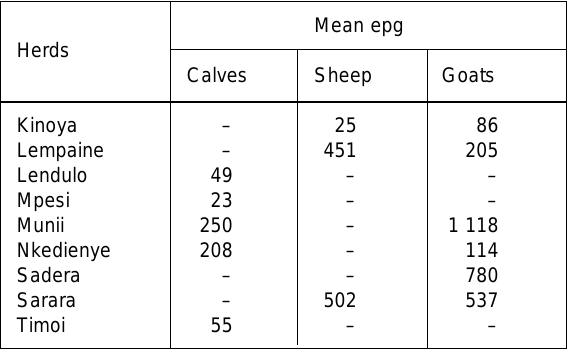
TABLE 1 Mean epg of total nematodes in calves, sheep and goats from different herds in Magadi